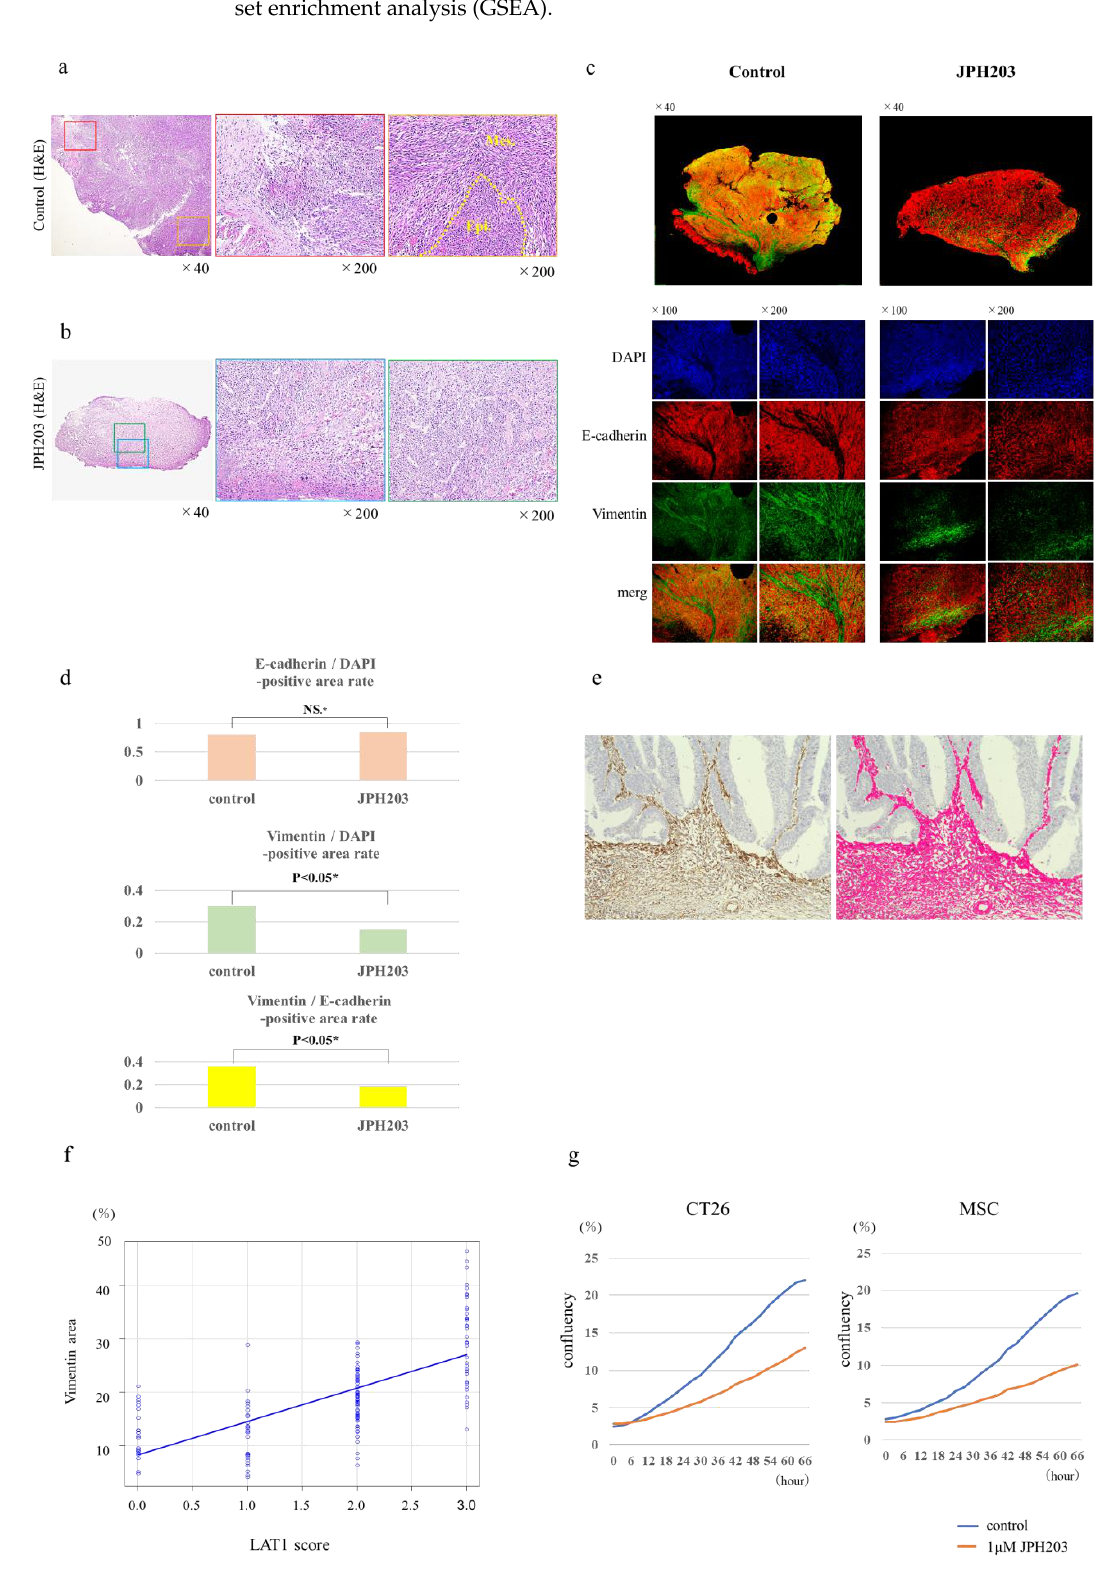
Figure 5. Validation for results of RNA sequences with mouse tumor, human specimens, and in vitro analysis ( a ) Histological analysis of CT26 + MSC mouse cecal orthotopic tumor without